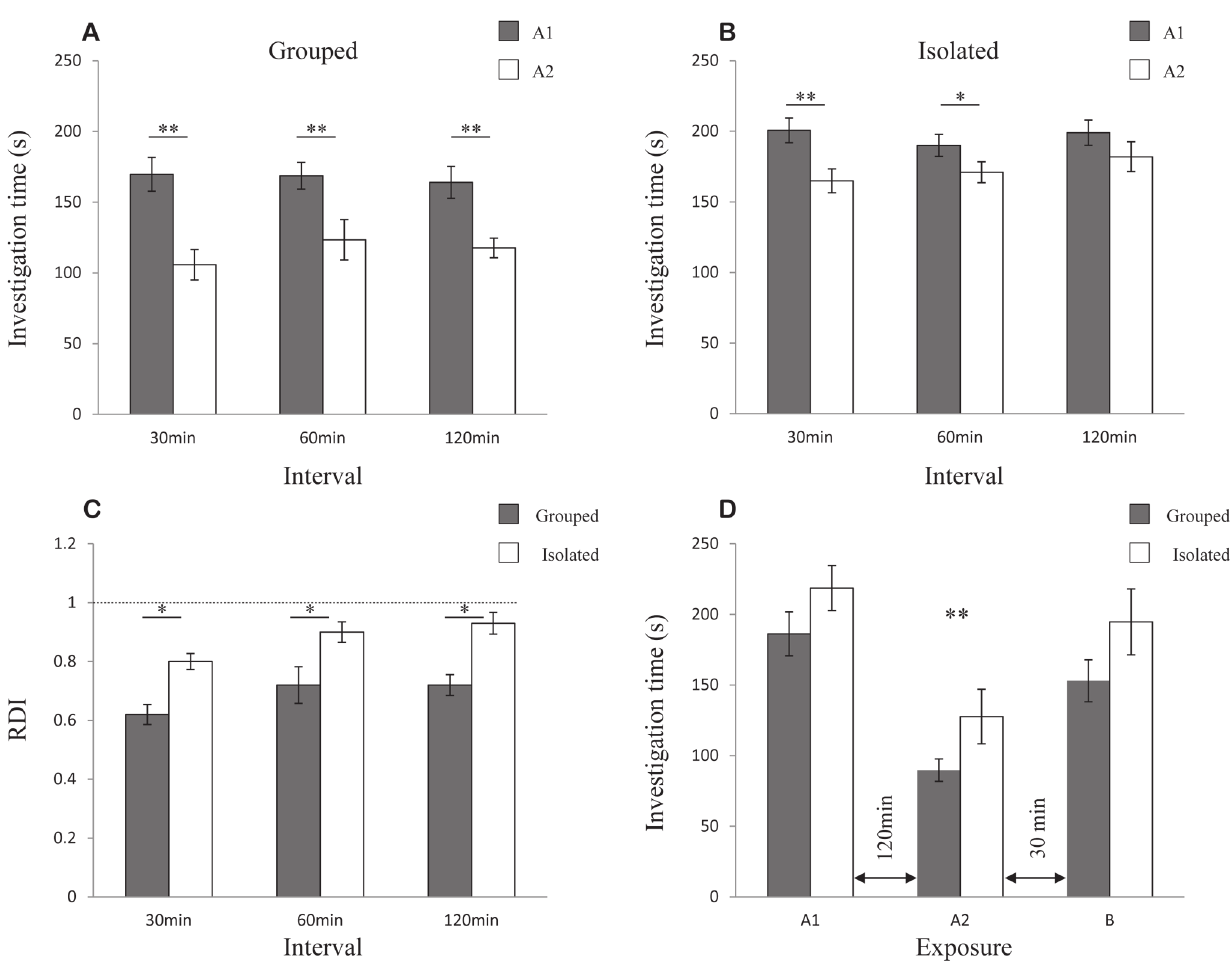
Figure 2. Housing conditions specifically impaired long-term SRM (mean ± SEM): A) Rats in group housing displayed a significant decrease in SIT during the second 5 min encounter (A2, empty bars) compared to the first (A1, gray bars), regardless of the time interval between the encounters. Paired t-test: ** p , 0.01, n=10 per group. B) Socially isolated rats displayed a significant decrease in SIT measured during the second encounter only for intervals of 30 and 60 min but not for a 120 min interval. Paired t-test: ** p , 0.01, * p , 0.05, n=10 per group. C) Isolated rats (empty bars) showed a significantly higher relative duration of investigation (RDI) than animals from group housing (gray bars) at all three time intervals. t-test: * p , 0.05, n=10 per group. D) Rats from group housing (gray bars, n = 10) and socially isolated rats (empty bars, n=10) similarly retained object recognition memory for 120 min following a single 5 min exposure. Both groups showed a significant decrease in investigation time during the second exposure to an object (A2), compared with the first exposure (A1) 120 min earlier and compared with exposure to a novel object (B) 30 min later. Repeated ANOVA, mixed model, F (2,36) =26.1, p , 0.001, no interactions ( p . 0.05), Bonferroni post hoc : ** p , 0.01 between exposures, no difference between groups ( p .